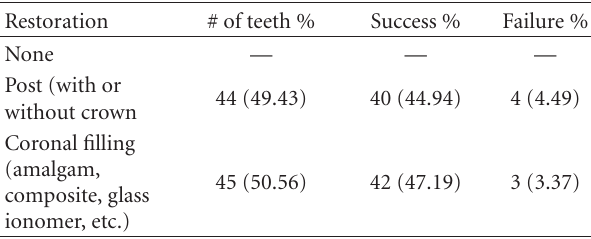
Table 5: Relationship of final restoration to treatment results in root canals filled with gutta-percha and